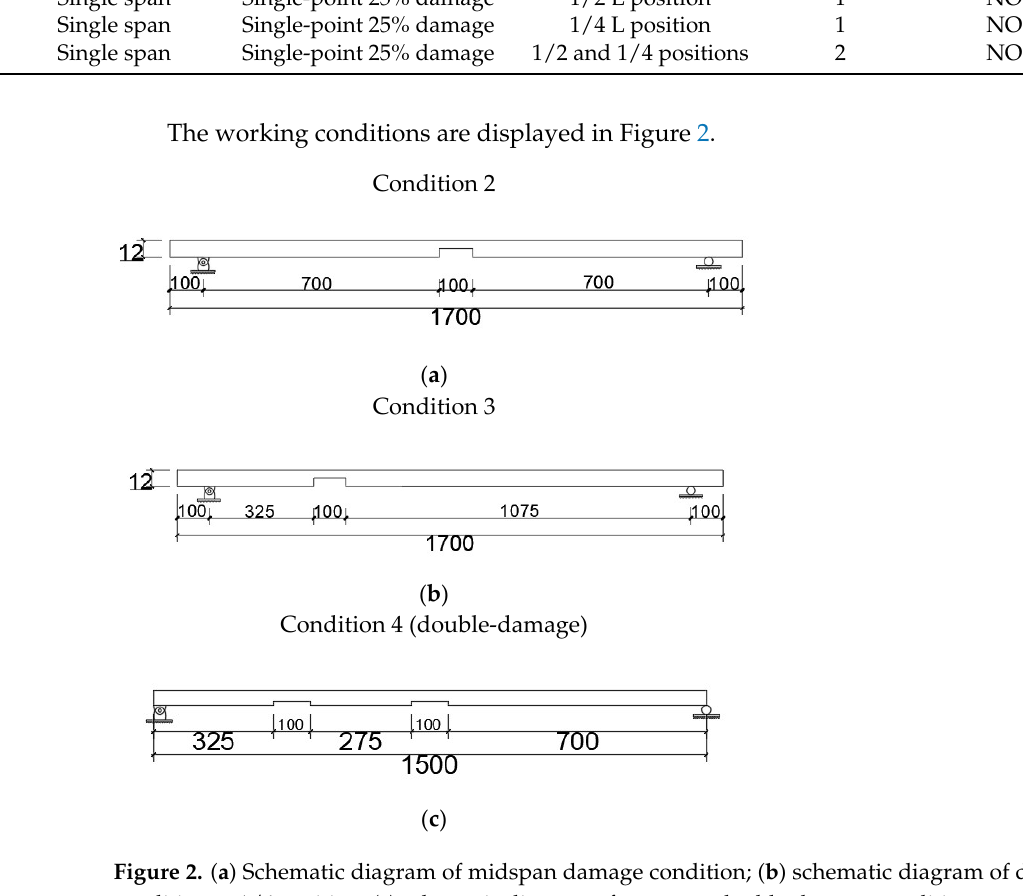
Table 1. Damage conditions.